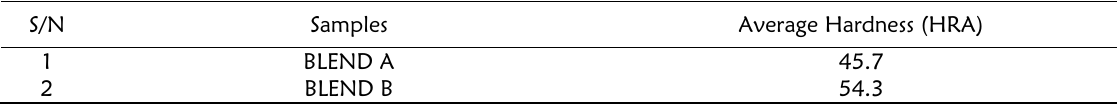
Table 4: Hardness value of